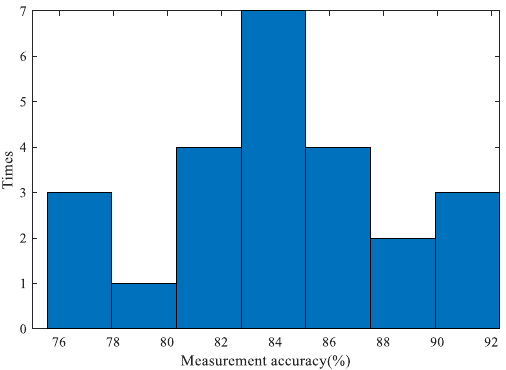
Figure 18. The histogram of individual fir measurement accuracies.